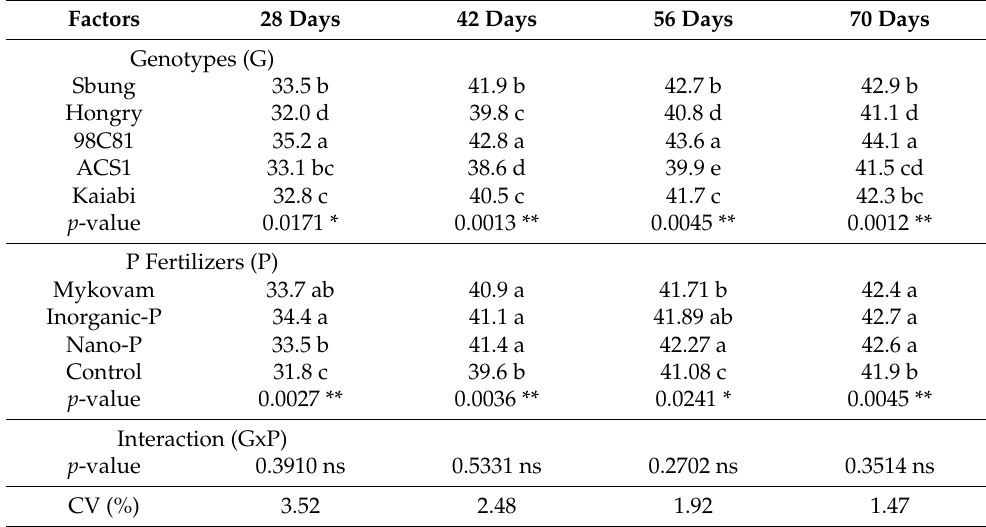
Table 8. Leaf chlorophyll index, as affected by genotypes and P fertilizer